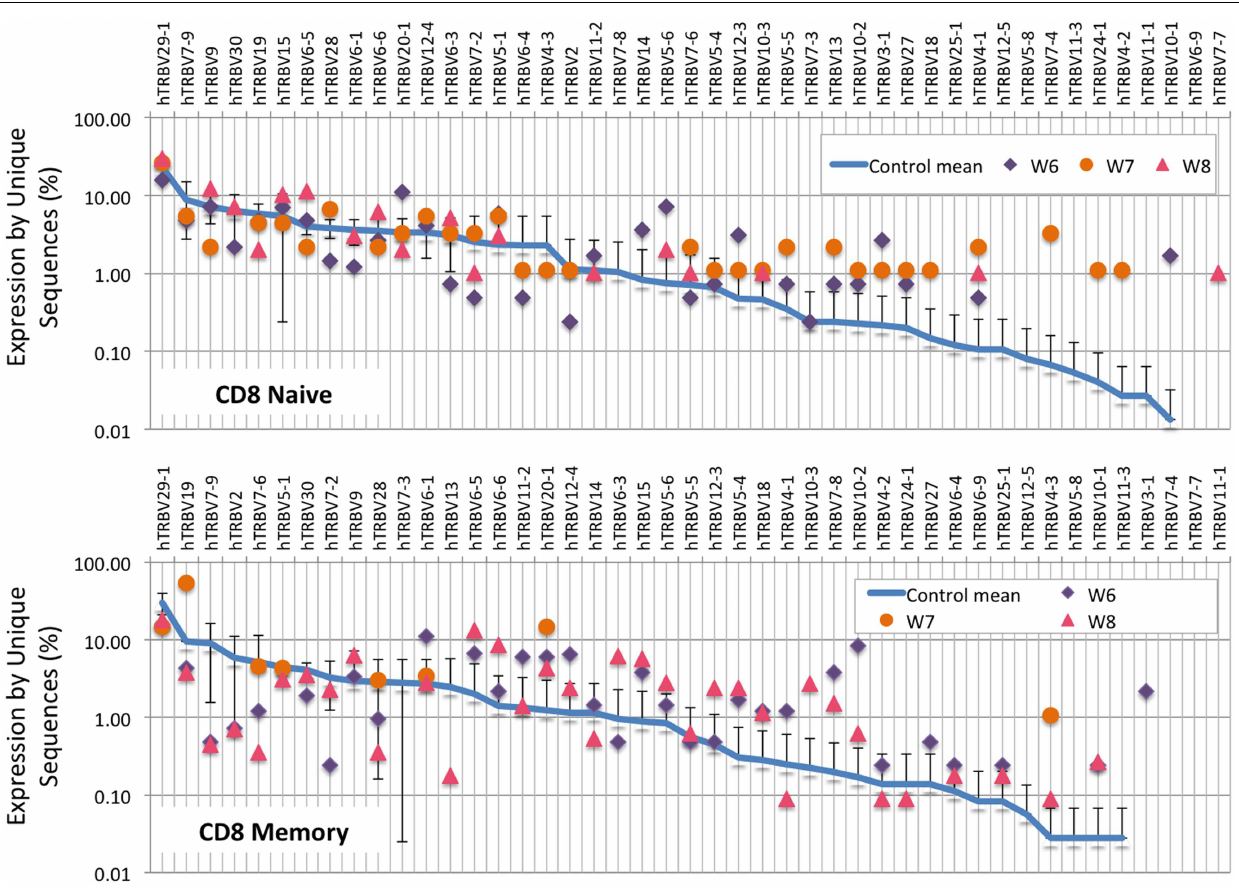
FIGURE 8 | TRBV gene in CD8 + naive and memory lymphocytes from healthy controls and patients withWAS .The frequency of usage of individual TRBV genes in unique TRB sequences is displayed for CD8 + naïve